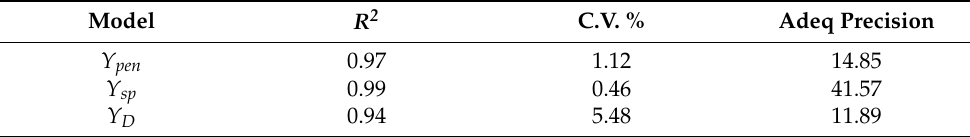
Table 5. Response surface fitting statistical analysis of physical properties.